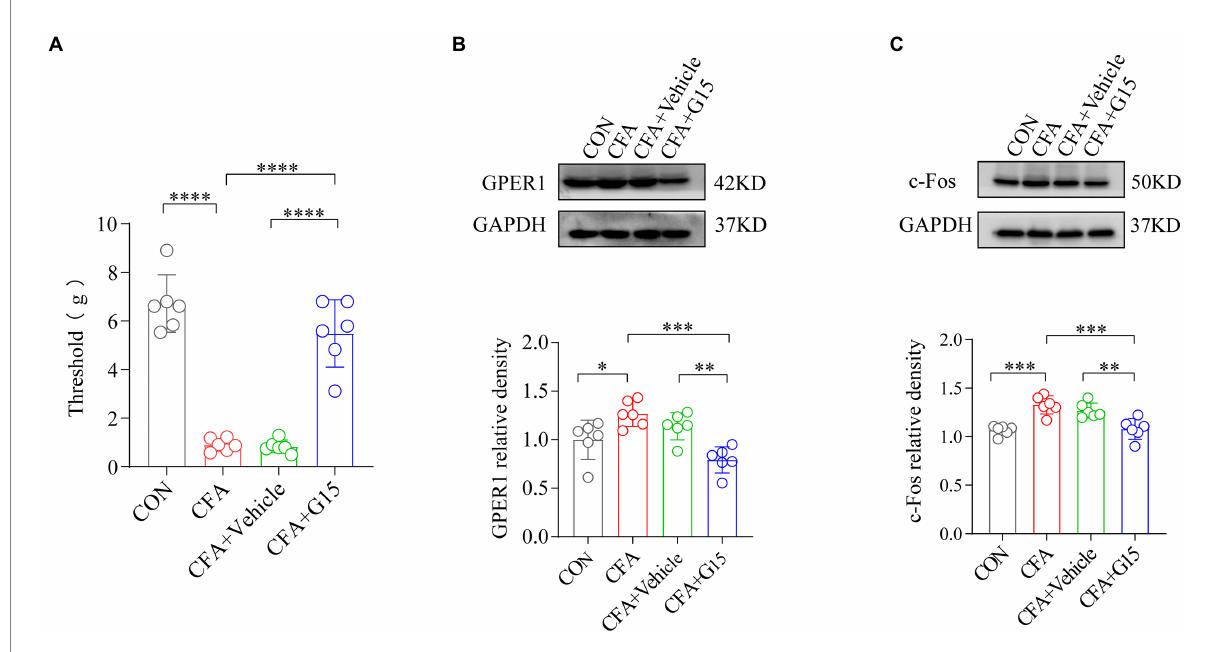
FIGURE 2 G15 attenuated CFA induced pain by reducing c-Fos and GPER1 expression. (A) Orofacial pain thresholds in rats. Compared with the CFA group, the orofacial pain thresholds of rats in the CFA + G15 group were significantly upregulated, and there was no significant difference between the CFA group and CFA + Vehicle group. WB detection of GPER1 and c-Fos expression in RVM. GPER1 (B) and c-Fos (C) protein levels were down- regulated in the CFA + G15 group compared with the CFA group, and there was no significant difference between the CFA group and CFA + Vehicle group. All data were normalized to the GAPDH control group. All statistical analysis was performed using one-way ANOVA followed by the Tukey post hoc test for multiple group comparisons. * p < 0.05, ** p < 0.01, *** p < 0.001, **** p < 0.0001. n = 6 per